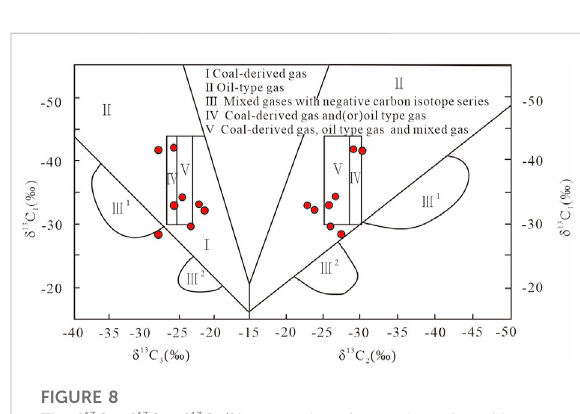
FIGURE 8 The δ 13 C 1 - δ 13 C 2 - δ 13 C 3 / ‰ cross plot of natural gas found in the Dongpu